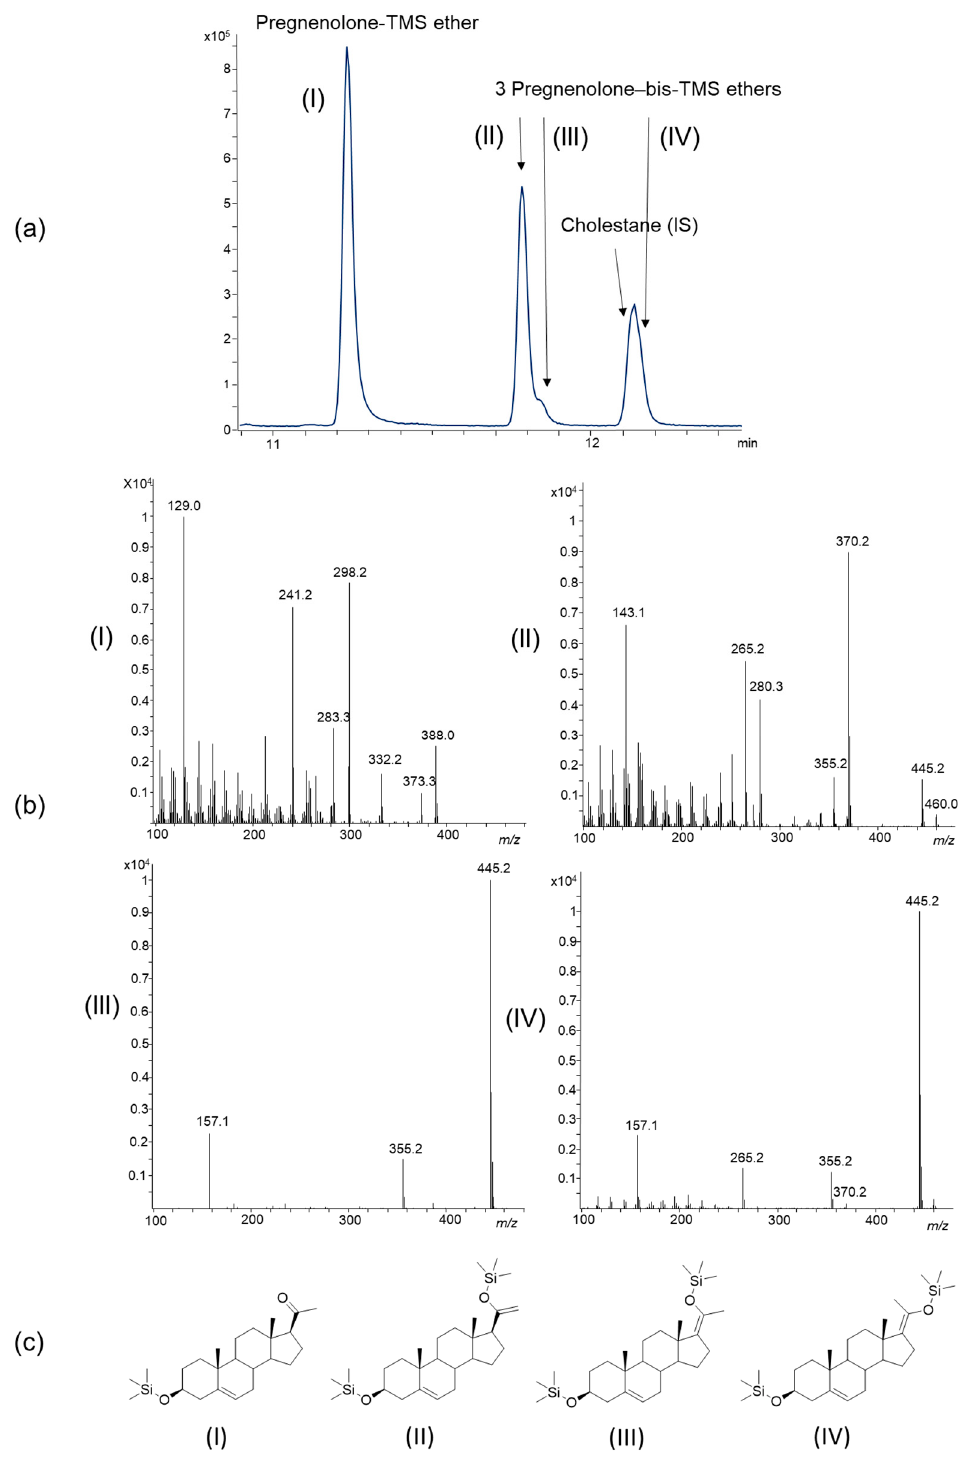
Figure 3. ( a ) Total ion chromatogram (TIC) of pregnenolone-TMS derivatives (containing cholestane (IS)). ( b ) Mass spectra of resulting pregenolone TMS ethers peaks (I)–(IV) after derivatization with N -methyl- N -trimethylsilyltrifluoroacetamide (MSTFA) / N -trimethylsilylimidazole (TSIM) (9:1). ( c ) Structures of pregnenolone-mono-TMS ether (I) and pregnenolone-bis-TMS ethers (II–IV) [33]; for chromatographic and mass spectral characteristics see Supplementary Table S1.